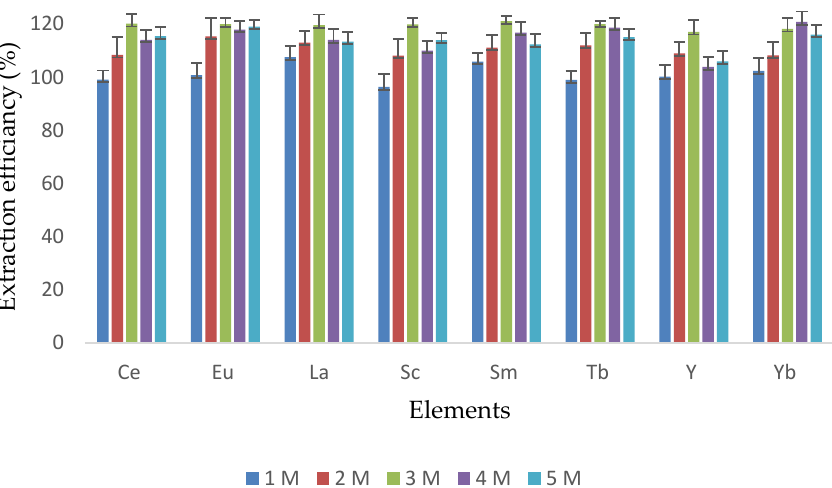
Figure 1. Effects of different HNO 3 concentrations (1–5 mol L − 1 ) for the extraction of REEs in coal samples. UAE conditions: [HNO 3 ] (optimized), sample mass (0.1 g), extraction time (30 min), UAE temperature (80 °C), UAE frequency (high) and replicates ( n = 3).